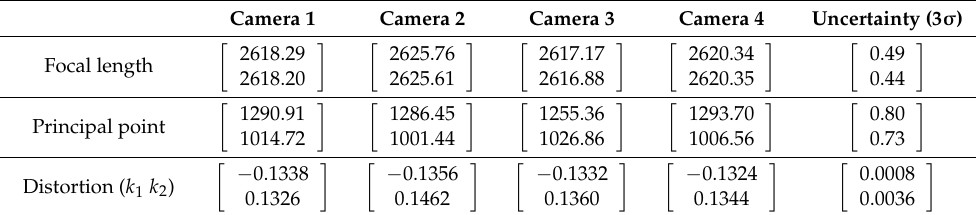
Table 1. The intrinsic parameters of four cameras.